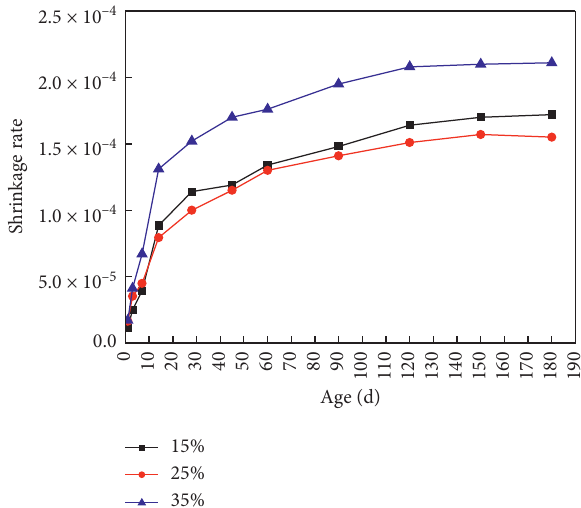
Figure 7: Effects of varying fly ash substitution levels on the CFA’s shrinkage rate.